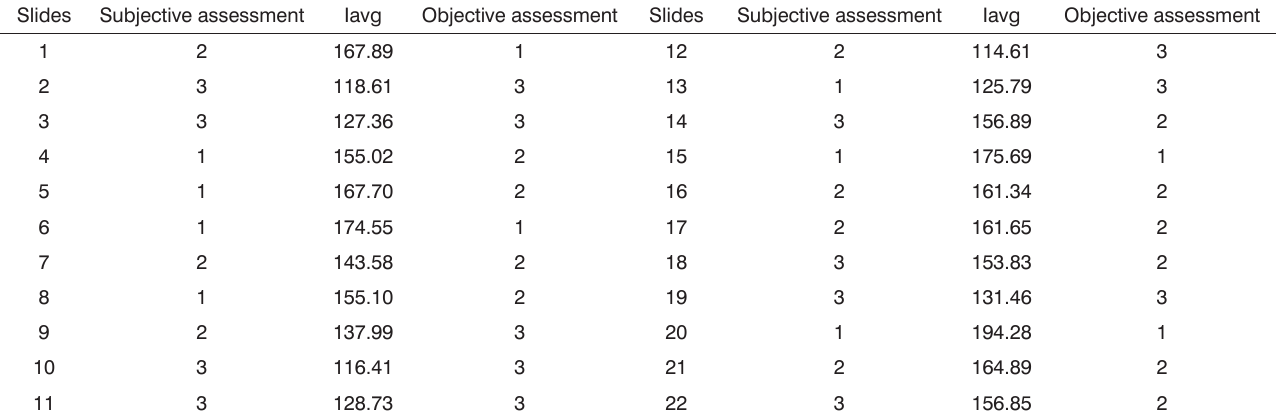
Table 2. Subjective assessments, Iavg in pixels and objective assessments of the intensities of immunohistochemical reactions in the group of slides stained with anti-TGF- α .